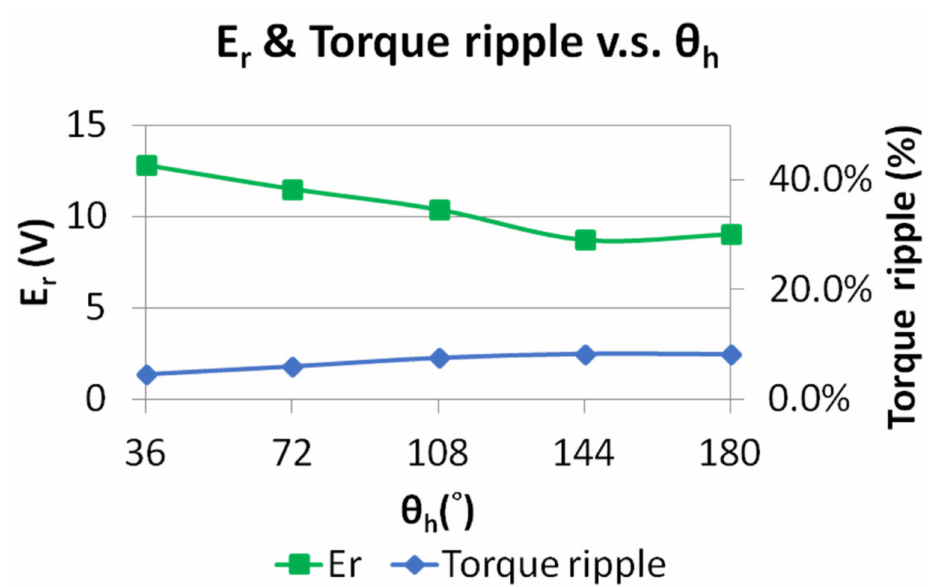
Figure 10. E r and torque ripple variation with θ h